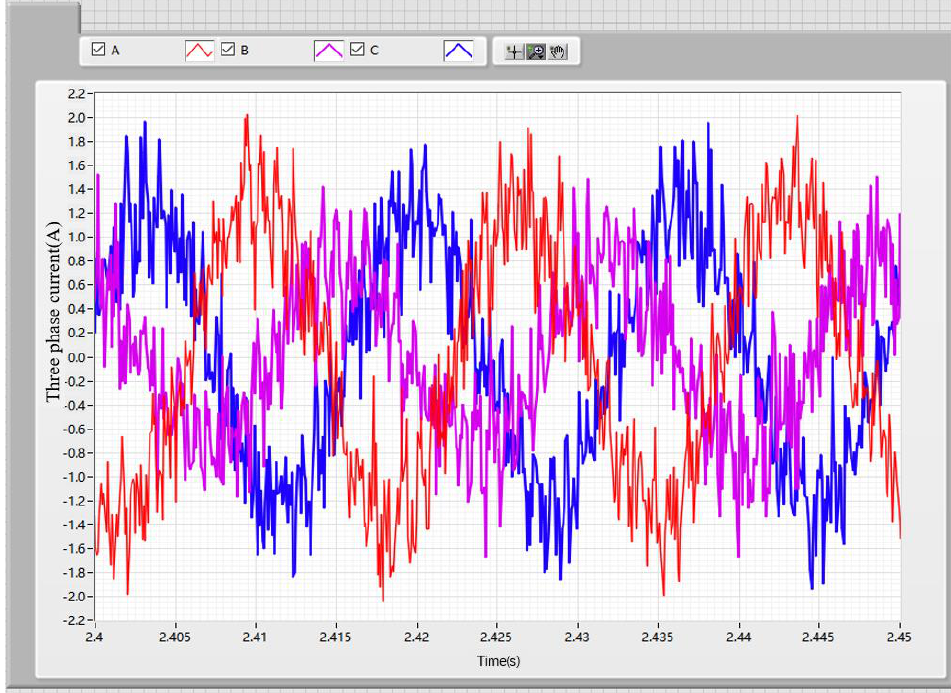
Figure 15. Three − phase current sampling waveform of a motor in a medium turn − to − turn short circuit